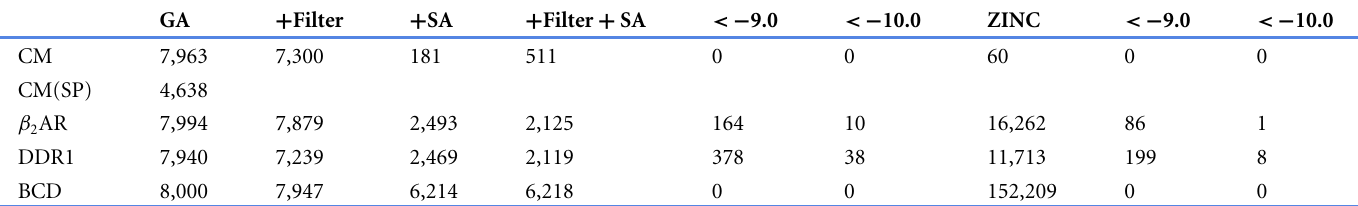
Table 2 Columns 2–5 list the number of molecules (out of a total of about 8,000) with docking scores higher than known binders (Table 1) without any structural screening (GA), with the group-filters ( + Filter), with a heuristic synthetic accessibility score (SA), and with both Fil- ter and SA. The HTVS scoring methodology is used except for CM(SP) where the SP scoring methodology is used. Columns 6 and 7 list the corre- sponding number molecules with scores lower than − 9.0 kcal/mol and − 10.0 kcal/mol obtained with + Filter + SA. The last three columns list the corresponding number of molecules obtained by docking all the molecules from the 250 K ZINC